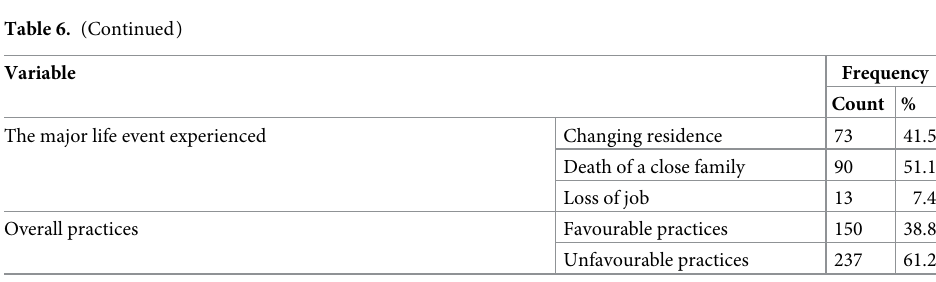
PLOS ONE | https://doi.org/10.1371/journal.pone.0262780 January 27,